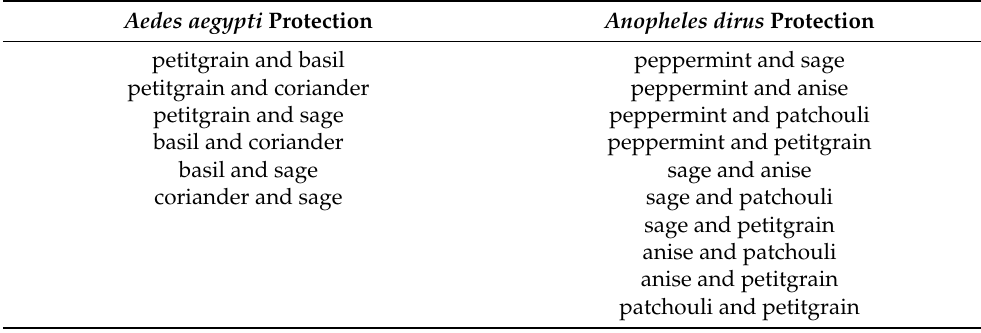
Table 2. Essential oil combinations used in the